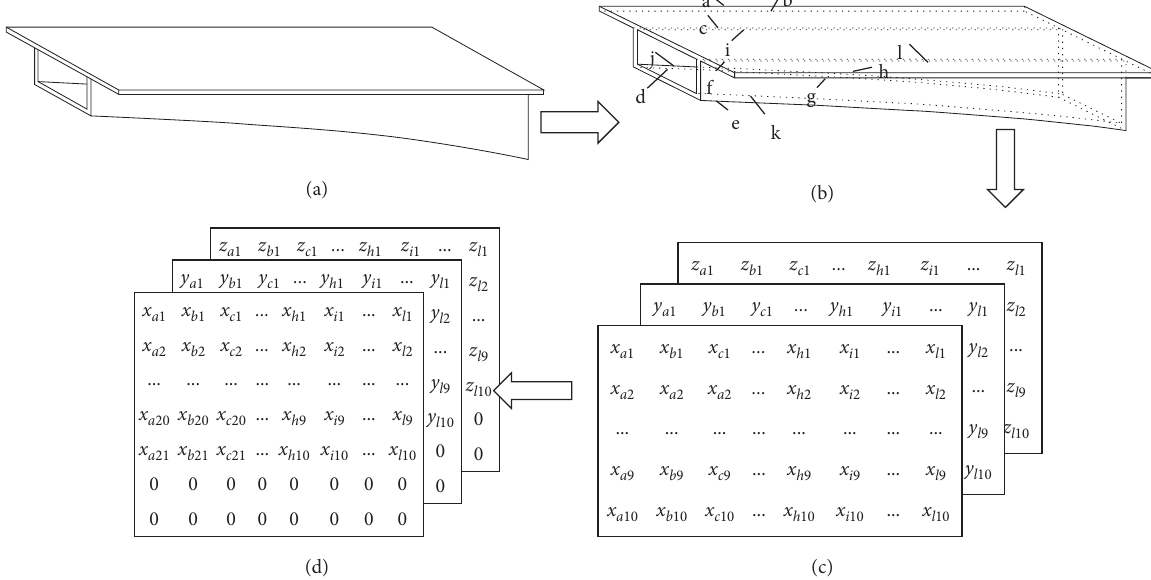
Figure 4: Process of forming input tensor for CNN. (a) Box grider. (b) Selecting ridgrine. (c) Form the input tensor. (d) Zero-padding to the shape of 12 × 12 × 3.